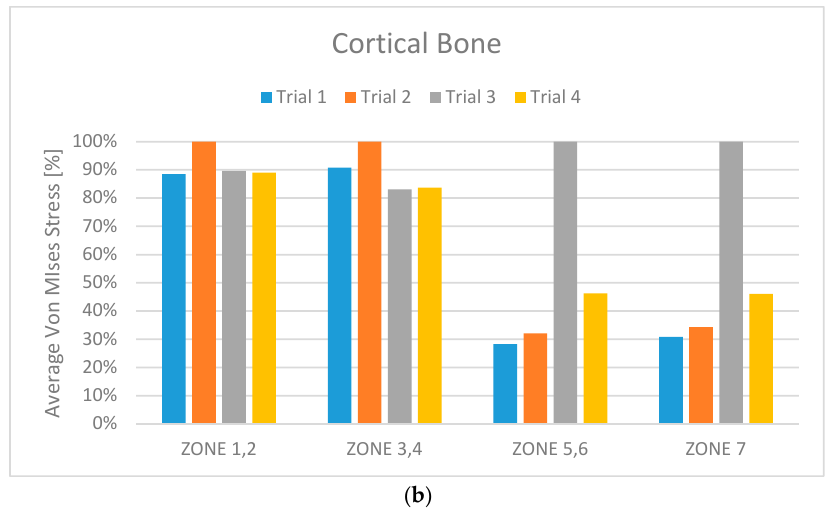
Figure 10. ( a ) Cortical bone stress distribution for each trial and for the different zones; ( b ) Cortical bone perceptual average Von Mises stress for each trial and for the different zones.